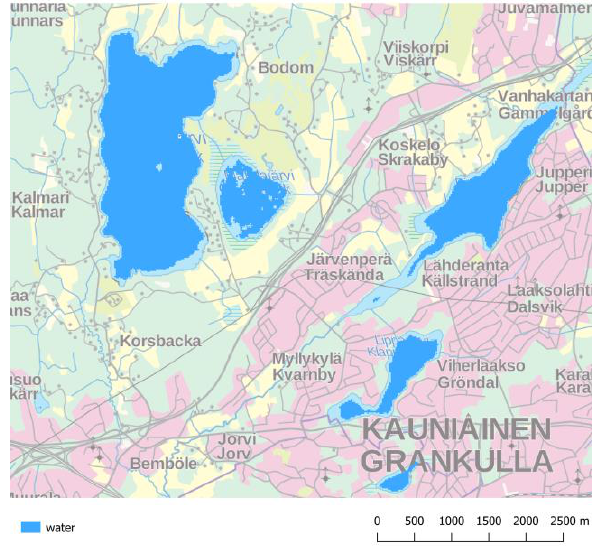
Figure 3: Water areas in the north western part (center background map from NLS